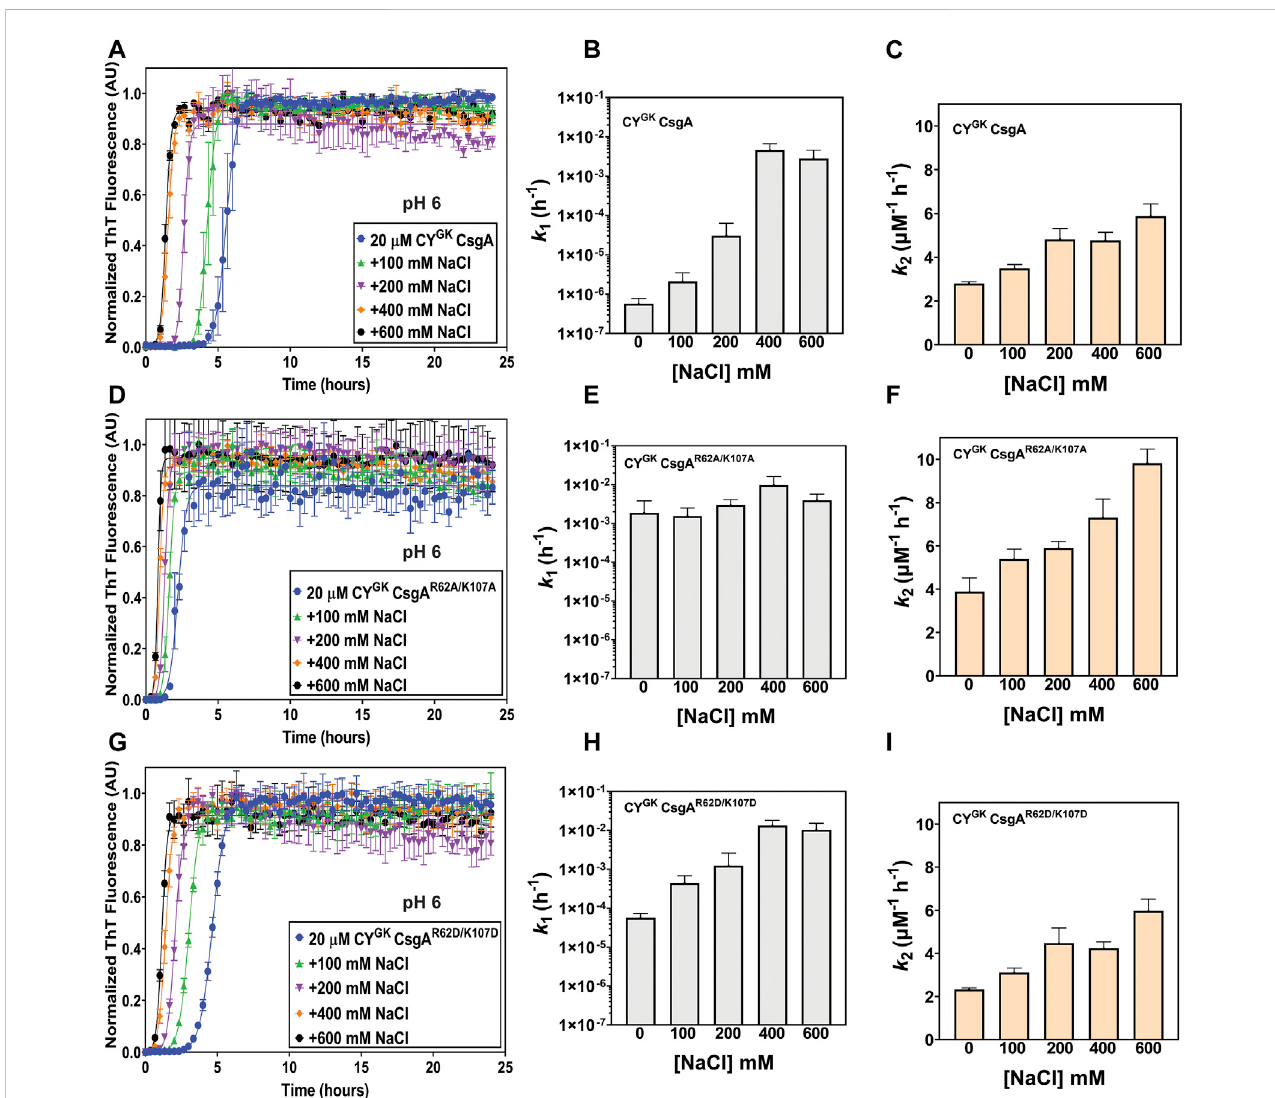
FIGURE 4 Salt-mediated charge screening reverses gatekeeping function. Analysis of aggregation kinetics of CY GK CsgA, CY GK CsgA R62A/K107A , and CY GK CsgA R62D/K107D at37 ° C,pH6inpresenceofincreasingNaClconcentrations. (A) ThT fl uorescenceassayofCY GK CsgA. (B) Nucleationrates k 1 ofamyloidosis(log scale) of CY GK CsgA. (C) Growth rates k 2 of amyloid fi ber propagation (linear scale) of CY GK CsgA. (D) ThT fl uorescence assay of CY GK CsgA R62A/K107A . (E) Nucleation rates k 1 of amyloidosis (log scale) of CY GK CsgA R62A/K107A . (F) Growth rates k 2 of amyloid fi ber propagation (linear scale) of CY GK CsgA R62A/K107A . (G) ThT fl uorescence assay of CY GK CsgA R62D/K107D . (H) Nucleation rates k 1 of amyloidosis (log scale) of CY GK CsgA R62D/K107D and (I) Growth rates k 2 of amyloid fi ber propagation (linear scale) of CY GK CsgA R62D/K107D . (Error bars represent SEM for ThT assay and SD for k 1 and k 2 of three